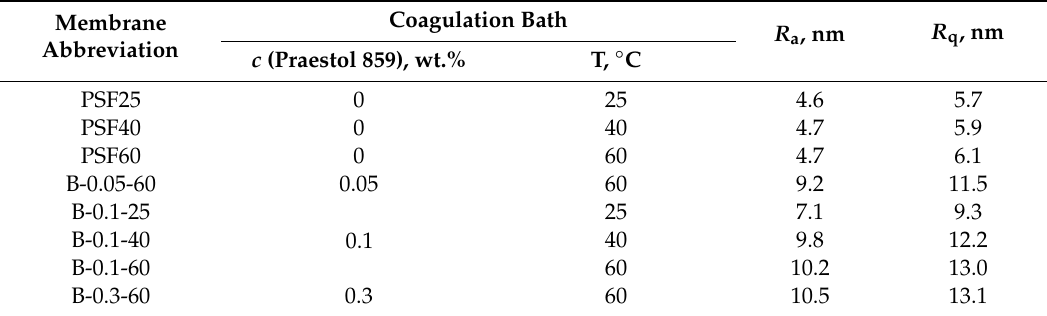
Table 4. Surface roughness parameters of reference PSF membranes and PSF membranes, prepared using Praestol 859 aqueous solution as a